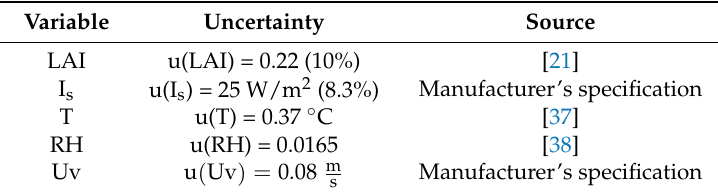
Table 3. The uncertainty of each